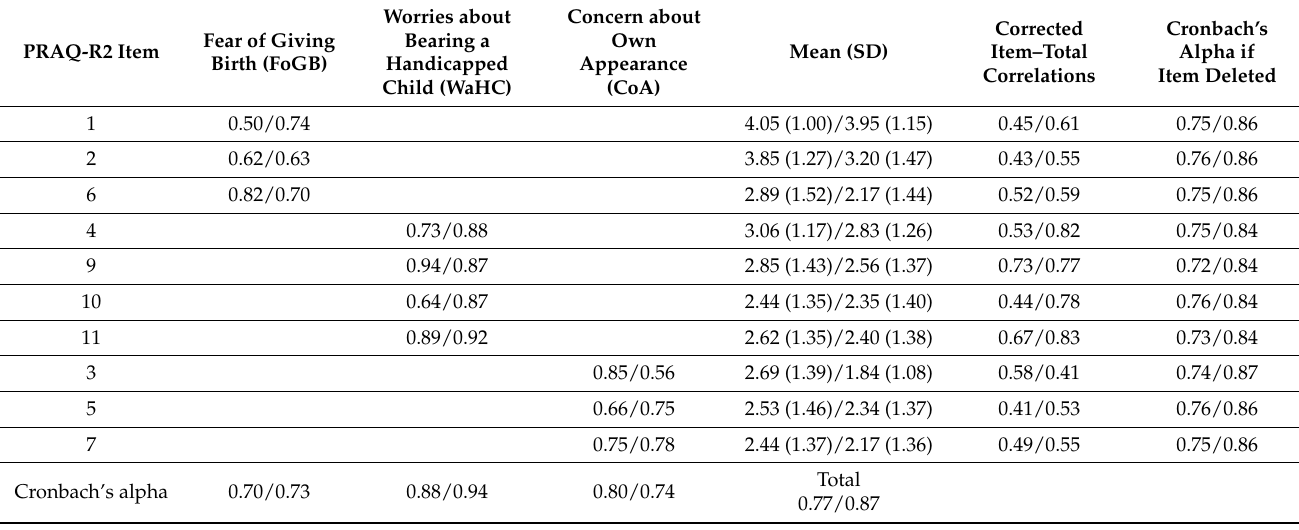
Table 3. Standardized factor loadings and item–total correlations for the PRAQ-R2 in primiparous and multiparous women (primiparous/multiparous).